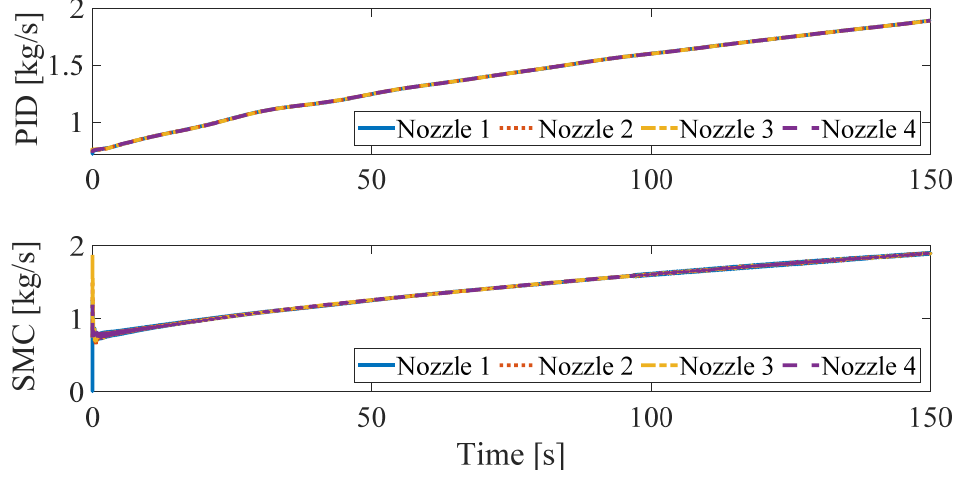
Figure 8. The mass flow rate of each nozzle.